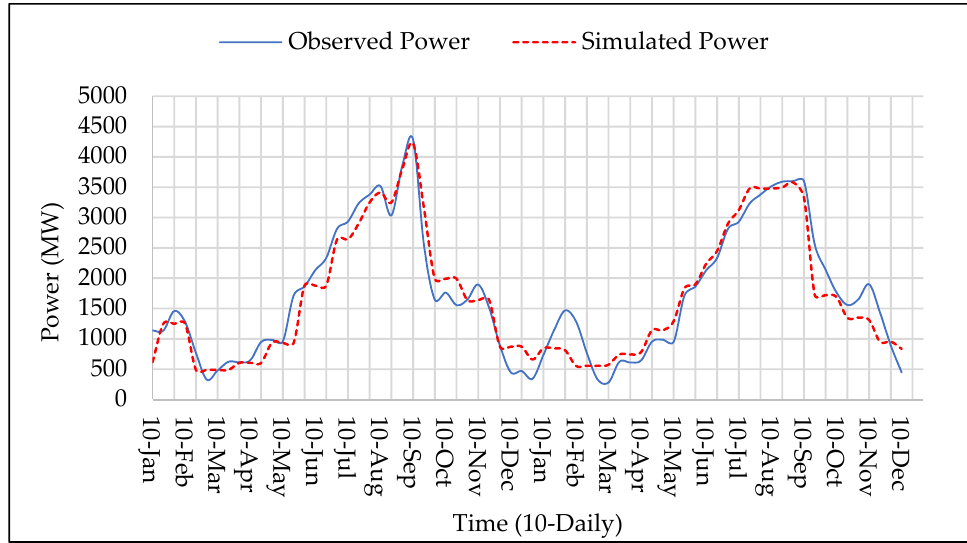
Figure 22. Calibration of the Model for Power Generation (2012 and 2013). The coefficient of efficiency, index of agreement and run-off ratio indicate the satis- factory values for accuracy of the model as shown in Table 6. Table 6. Model efficiency parameters for Model Calibration year 2012 and 2013.